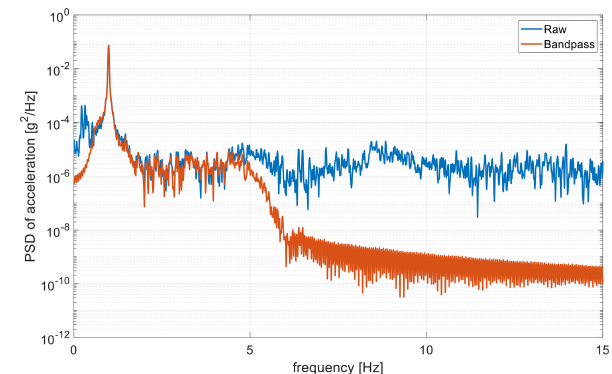
Figure 7. PSD of the raw or bandpass-filtered decay signal.